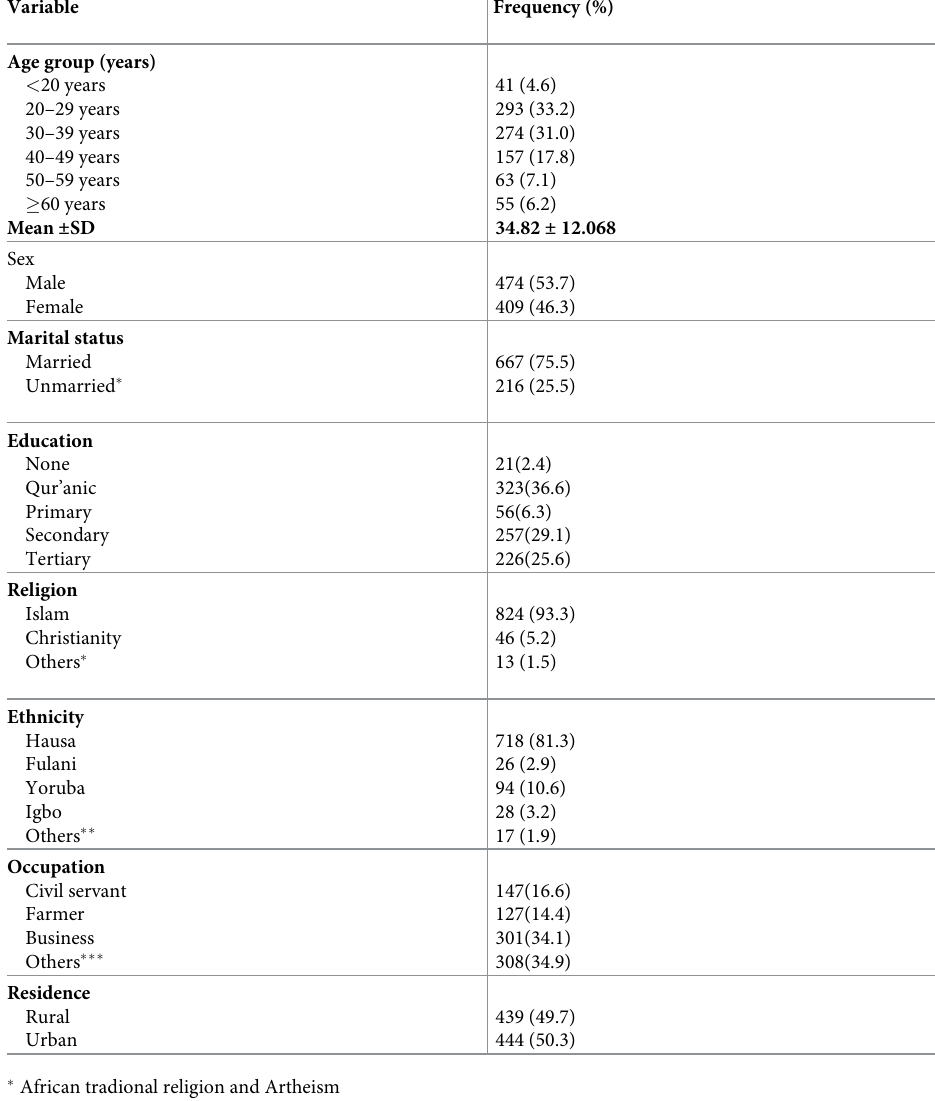
Table 1. Sociodemographic characteristics of